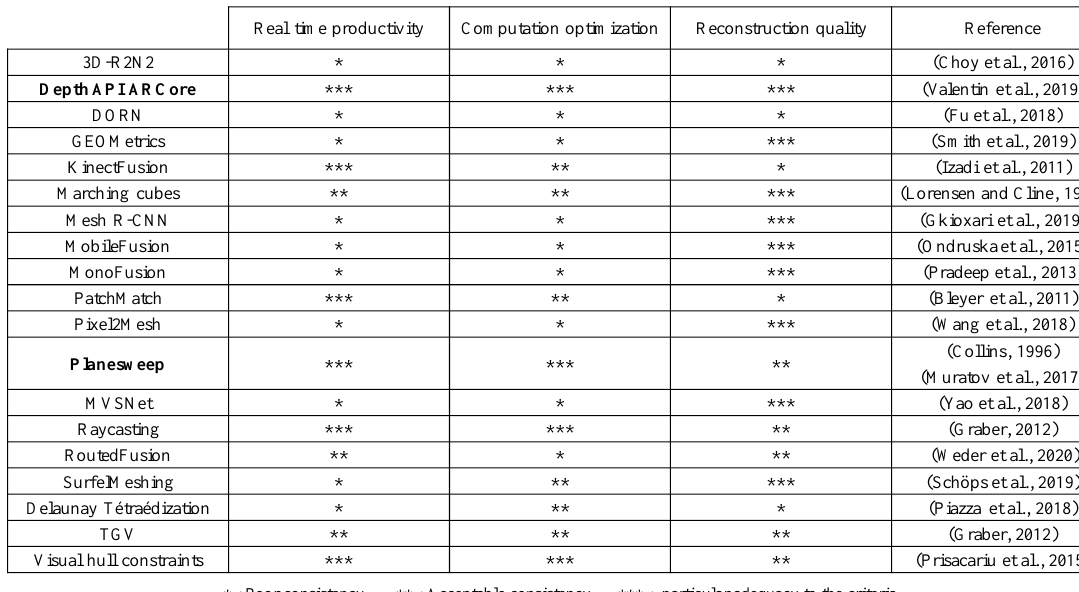
Table 1. Conclusion of our study concerning reconstruction